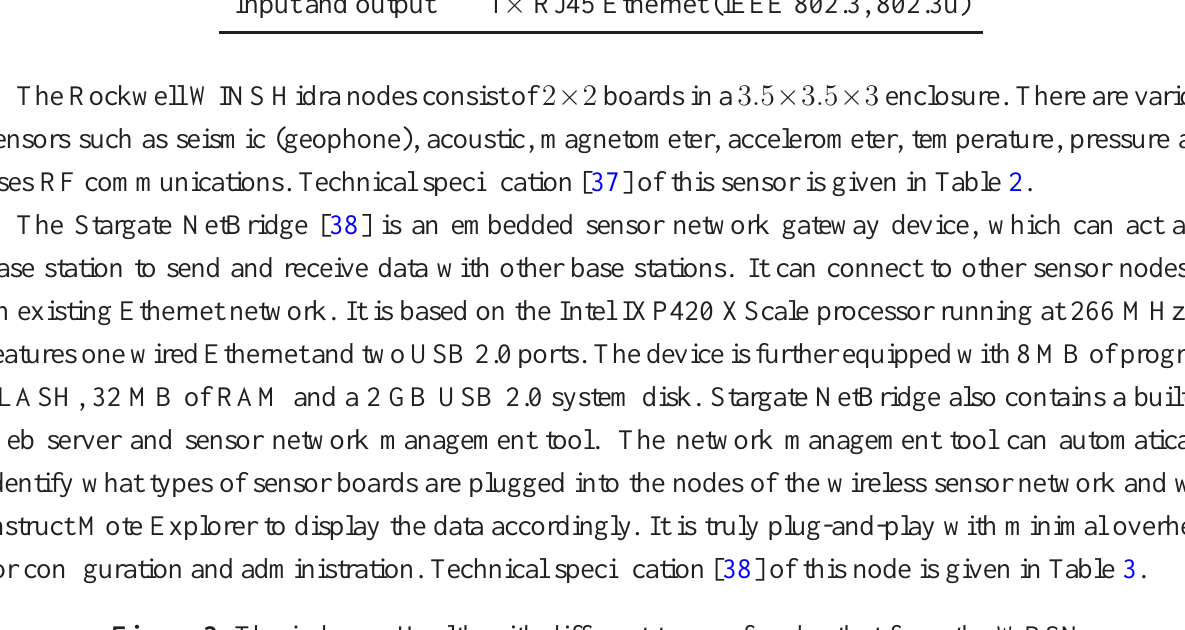
Figure 3. The indoor mHealth with different types of nodes that form the